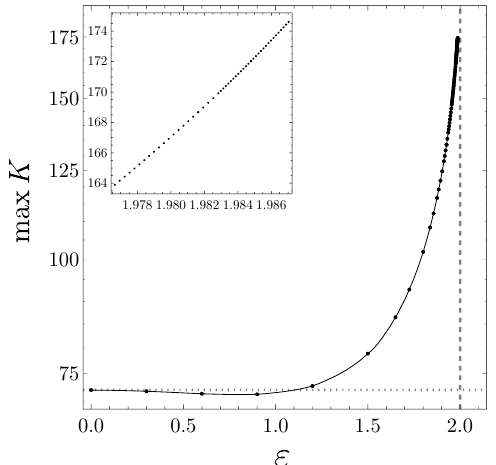
Figure 5 . Log-linear plot of the curvature scalar maximum against " , for a large black hole with T = 1 =(cid:25) . The dashed gridline marks the critical value of " , and the dotted gridline shows K max = 72 for a Schwarzschild-AdS 4 black hole. The inset is a log-log plot for high values of the rotation